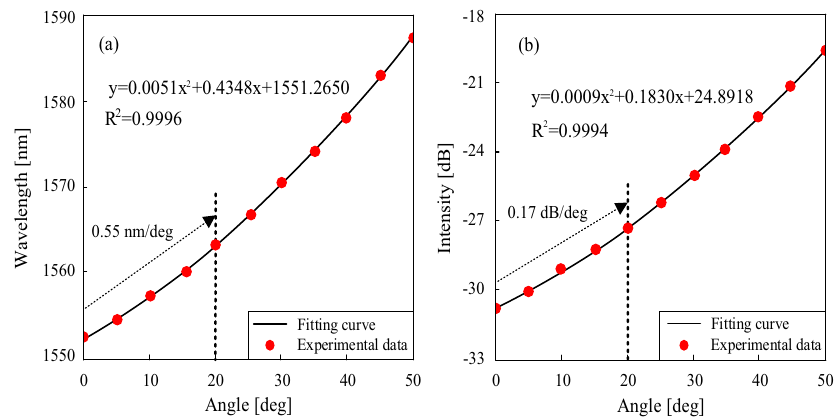
Figure 6. The wavelength ( a ) and intensity ( b ) response with respect to different tilt angles.